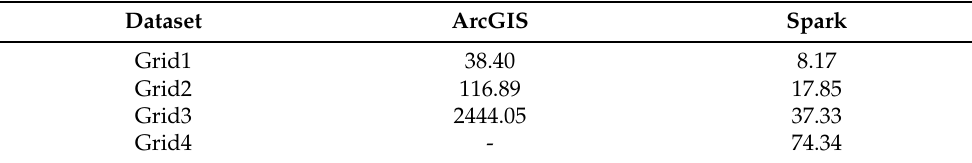
Table 3. Comparison of the execution times of ArcGIS and Spark (time unit: